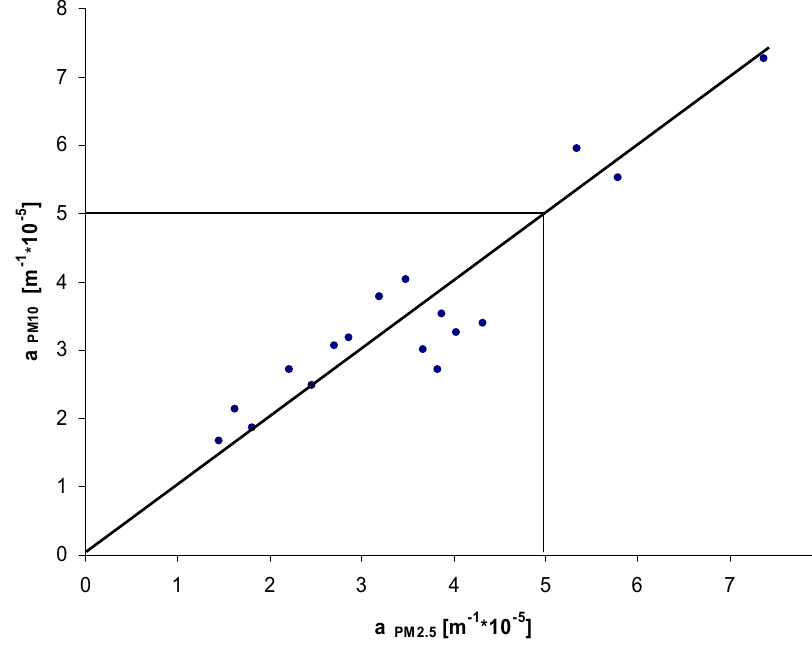
Figure 3. Absorption coefficient ( a ) of PM 10 vs. absorption of PM 2.5